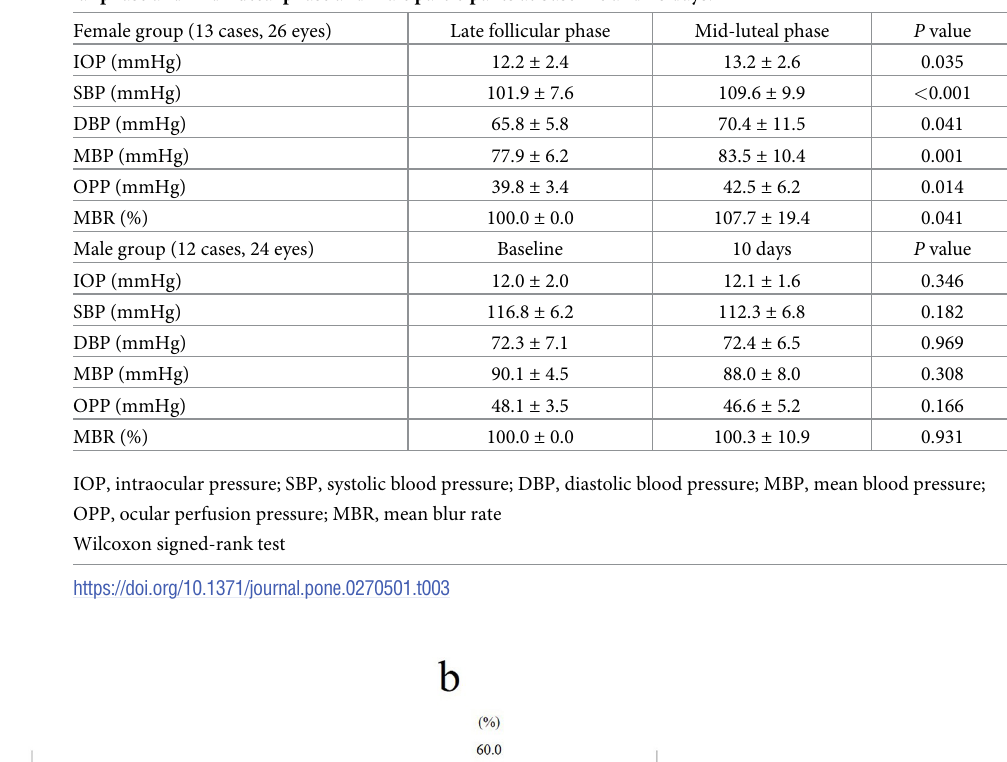
Table 3. Comparison of intraocular pressure and systemic factors between female participants in the late follicu- lar phase and mid- luteal phase and male participants at baseline and 10 days.